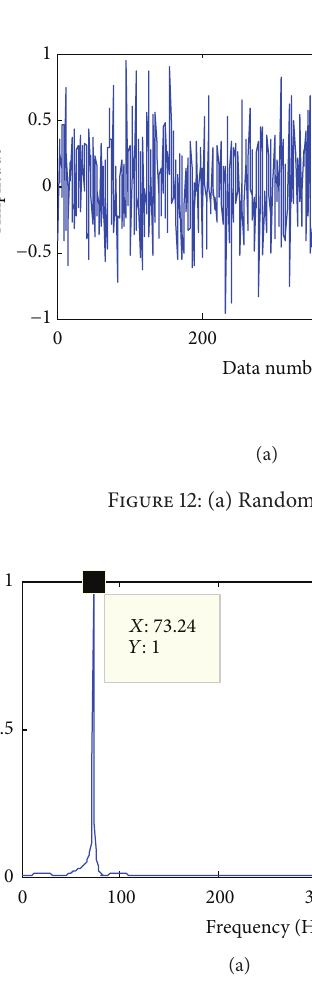
Figure 13: (a) Fault characteristic frequency and (b) twice the fault characteristic frequency.